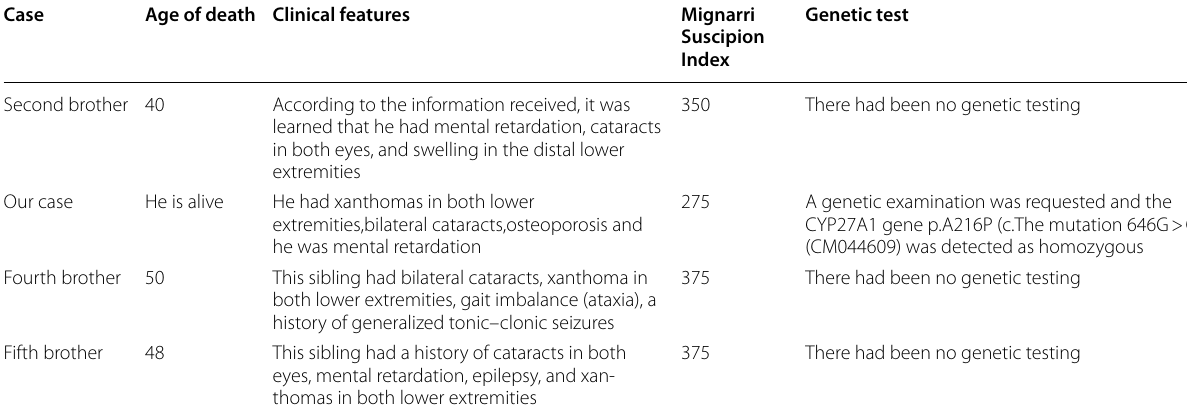
Table 1 Brief summary of all siblings with clinical features of the